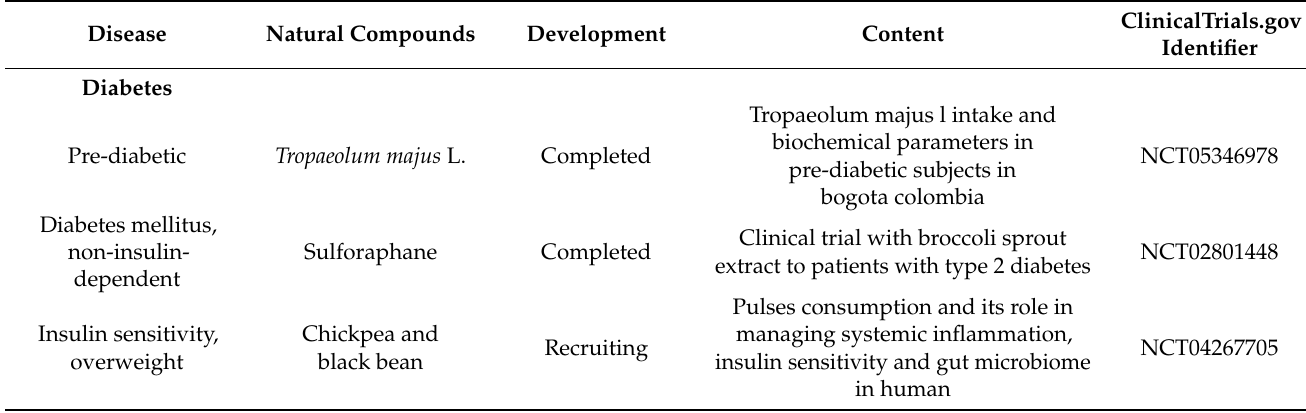
Table 1. Summary of the Nrf2 inducer/activators drug discovery in chronic diseases registered in ClinicalTrials.gov of NIH (https://www.clinicaltrials.gov/, accessed on 18 December